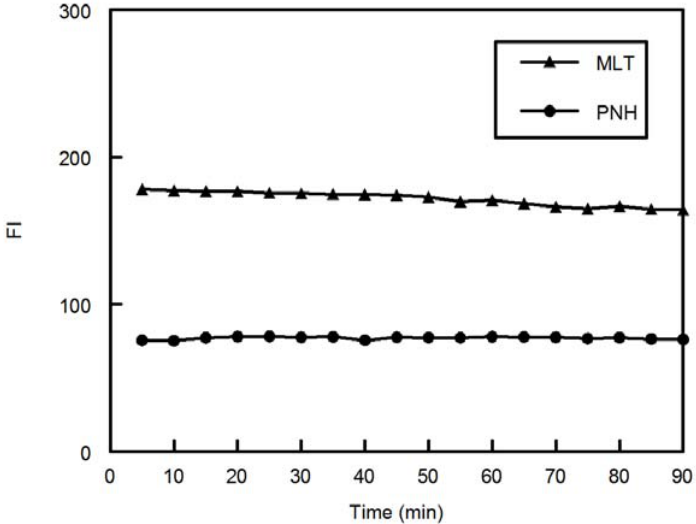
Figure 6. Effect of time on FI of MLT and PNH (100 ng mL − 1 ).